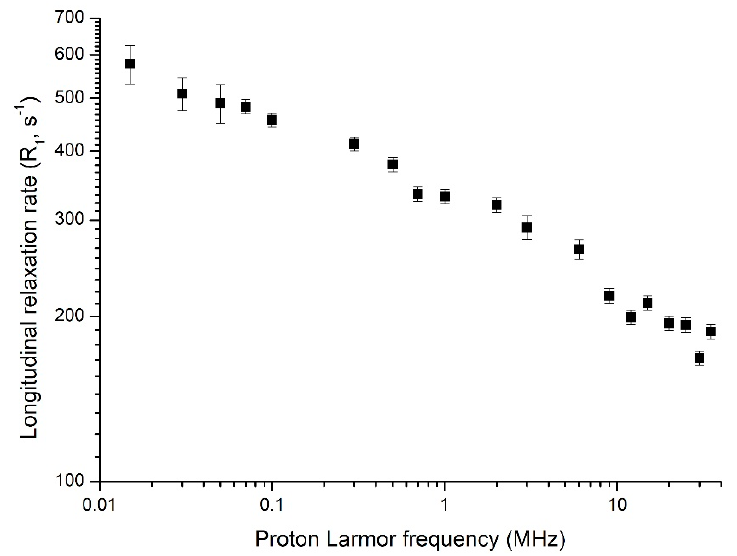
Figure 8. NMRD profile of one of the water–saturated soils analyzed in [57] (unpublished data). Owing to the complexity of the dynamics of H 2 O molecules on the porous surface, the shape of the dispersion is not sigmoidal, such as in Figure 7, but stretched.